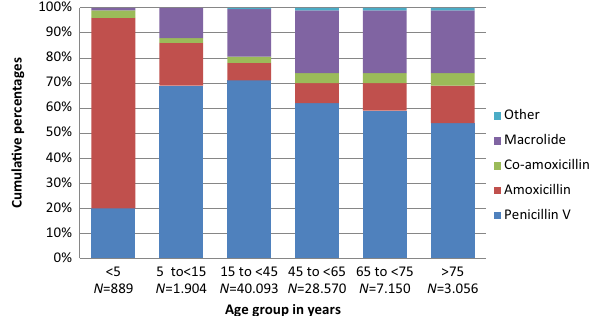
Fig. 4 Acute rhinosinusitis. Prescribing pattern by age group ( N = 81.662)